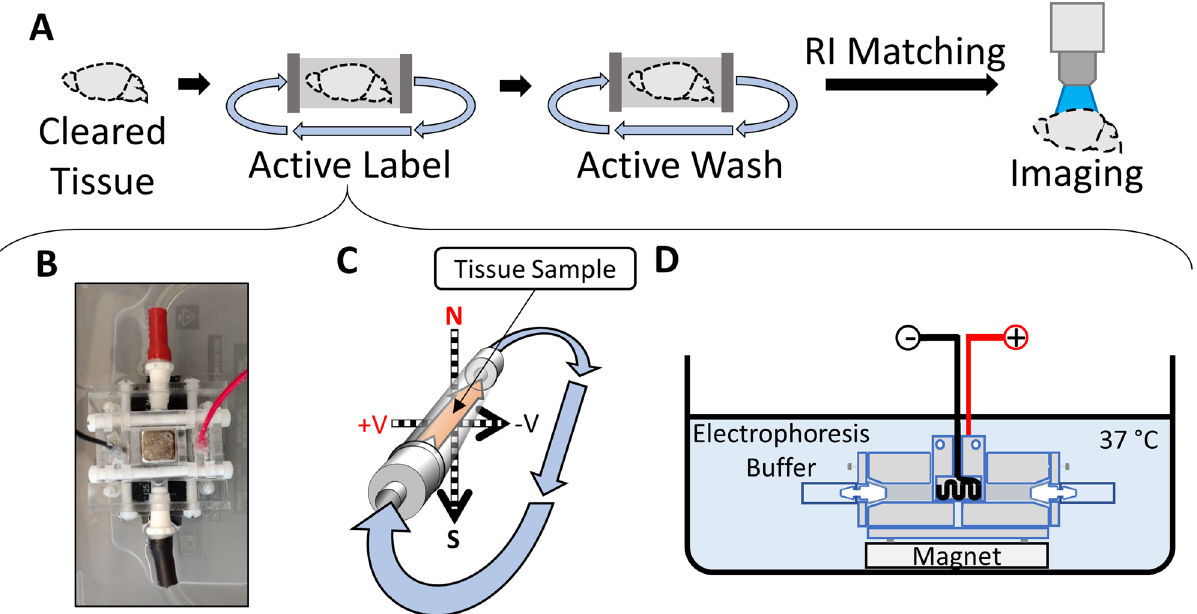
Figure 6. Overview of MHD-accelerated antibody labeling. ( A ) Illustration of the steps required to label and image tissue. ( B ) Picture of the MHD-assisted labeling device. ( C ) Schematic showing the tissue location inside the MHD-assisted labeling device. The direction of the MHD force is indicated by the orange arrow inside the dialysis tubing. The resulting direction of flow of the solution through the closed loop is indicated by the blue arrows. ( D ) Diagram of the antibody labeling device setup for a label. The device is submerged in a bath of electrophoresis buffer held at 37